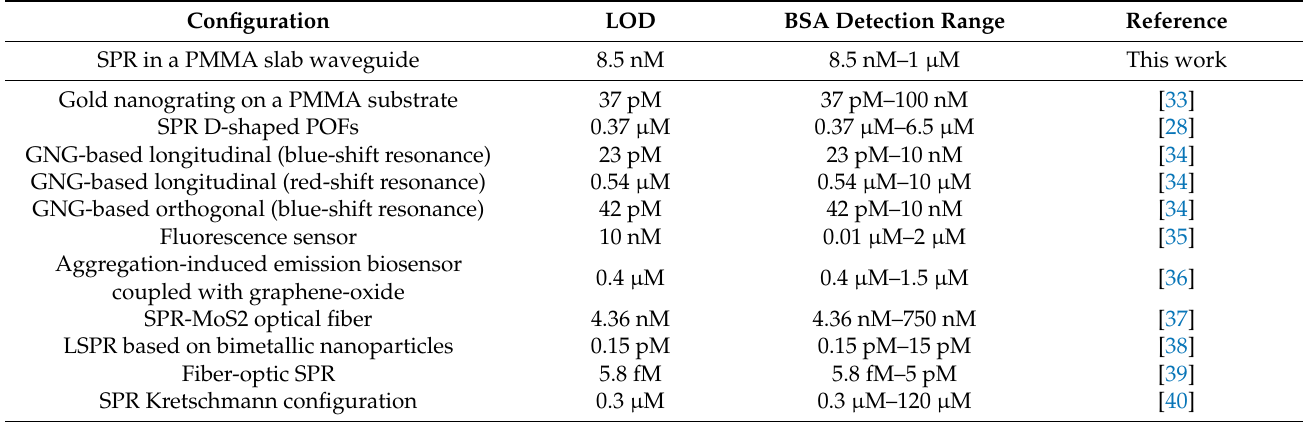
Table 3. Comparative analysis for several BSA